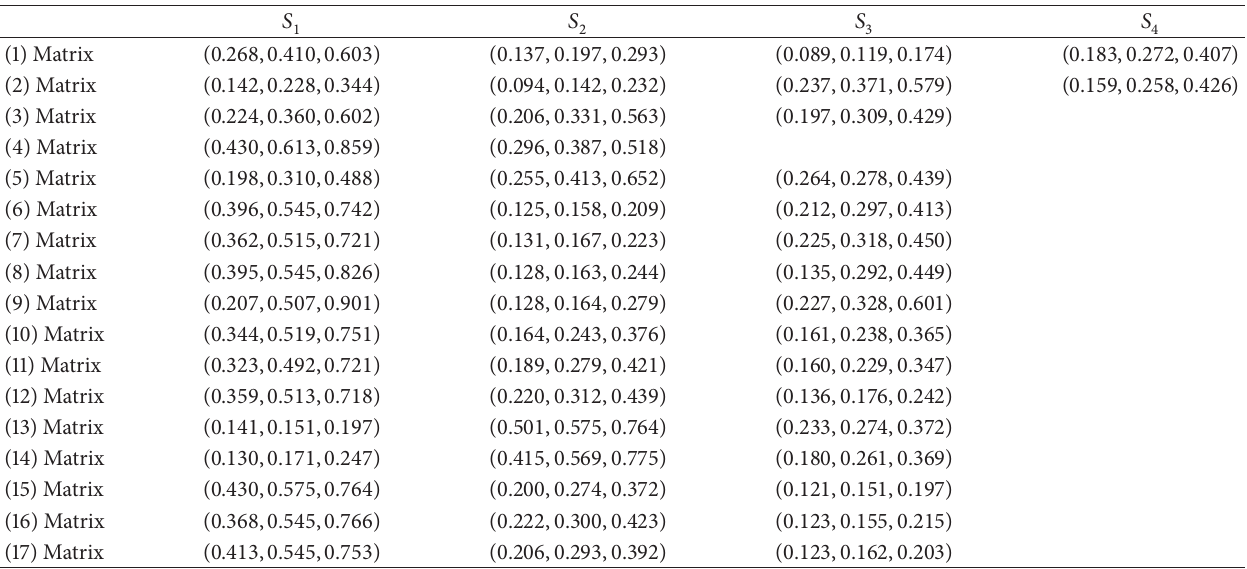
Table 5: Fuzzy synthetic extent values.